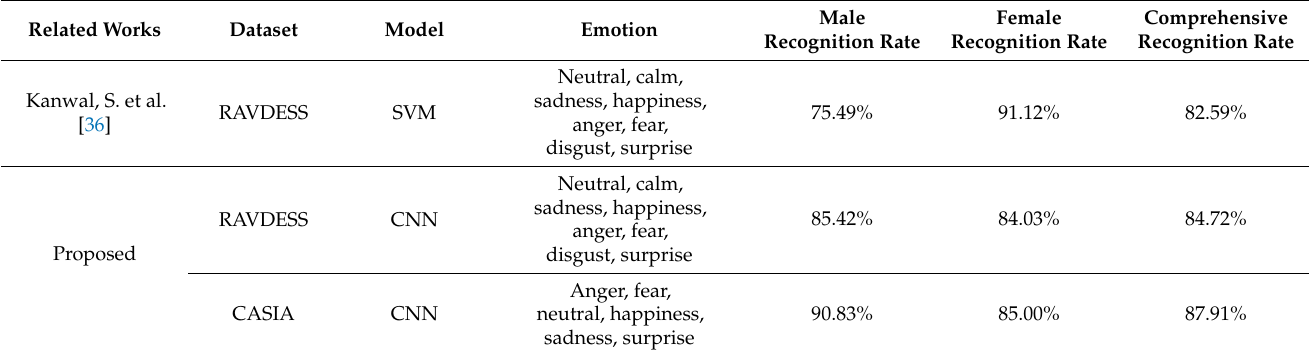
Table 5. Comparison of accuracy with algorithm based on gender